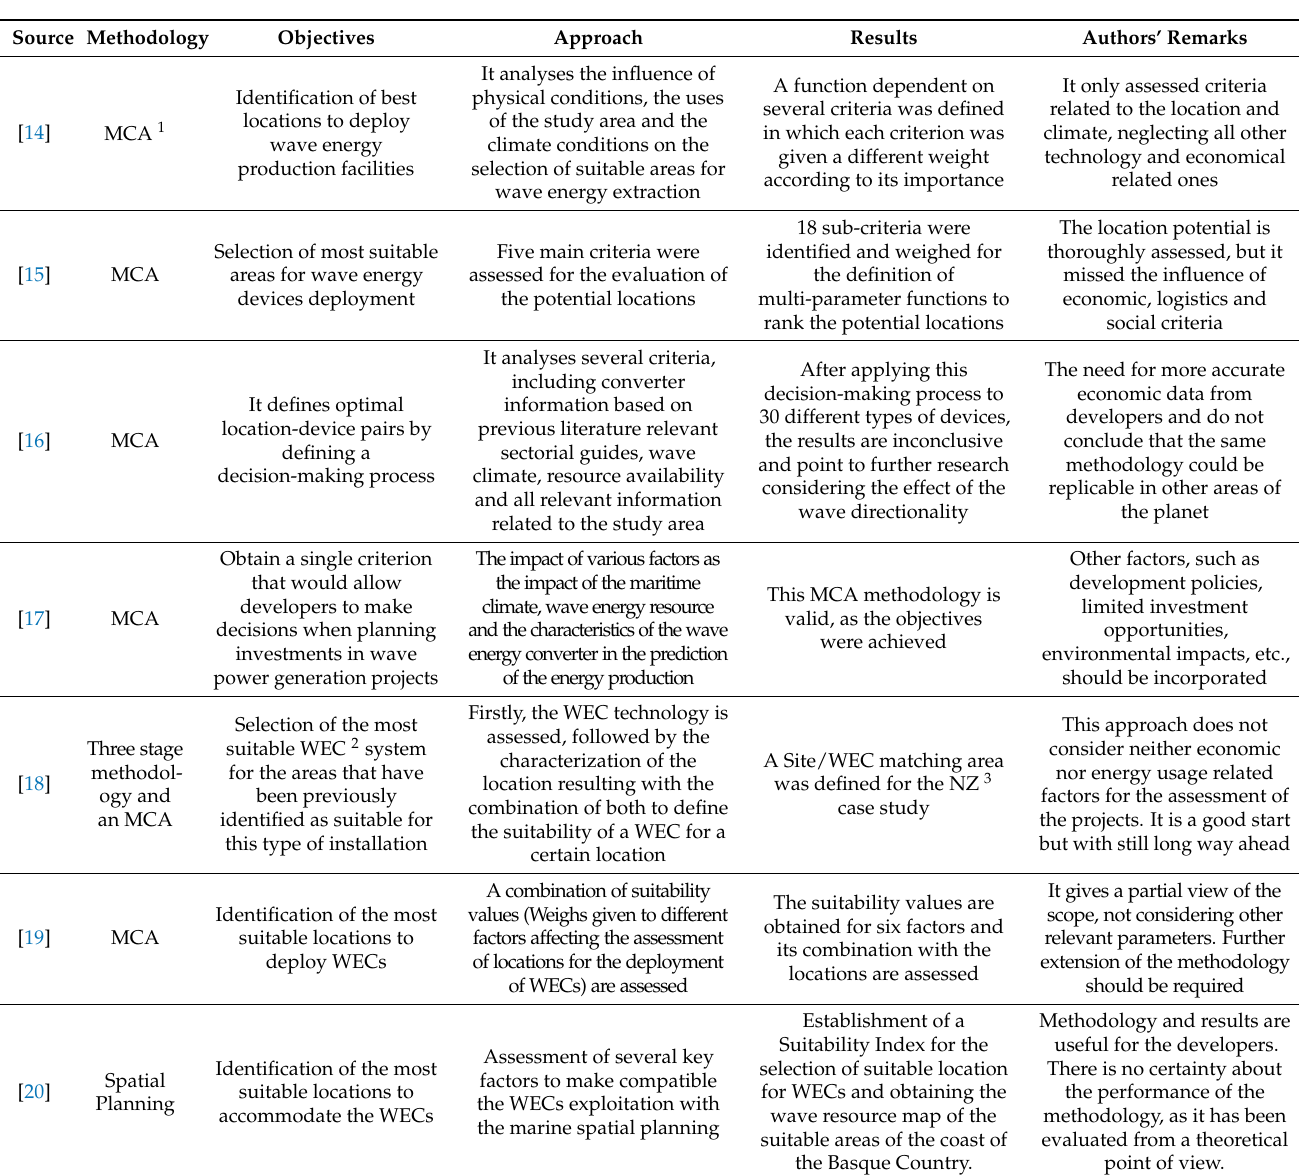
Table 1. Review of existing literature related to the selection of criteria for the assessment of wave energy installations. Own